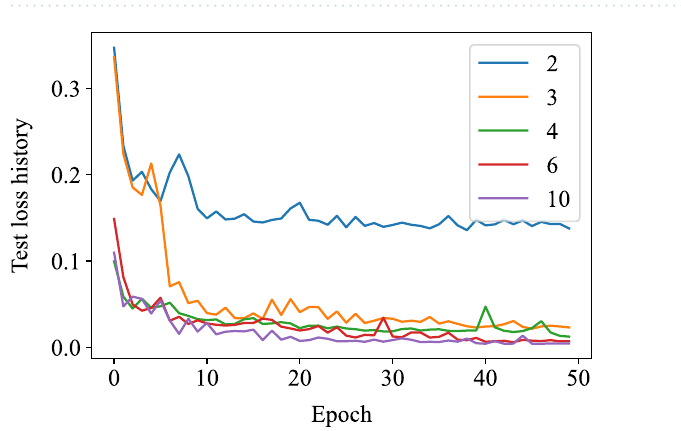
Figure 4. Workflow of CNN-GP-NARX Surrogate model.